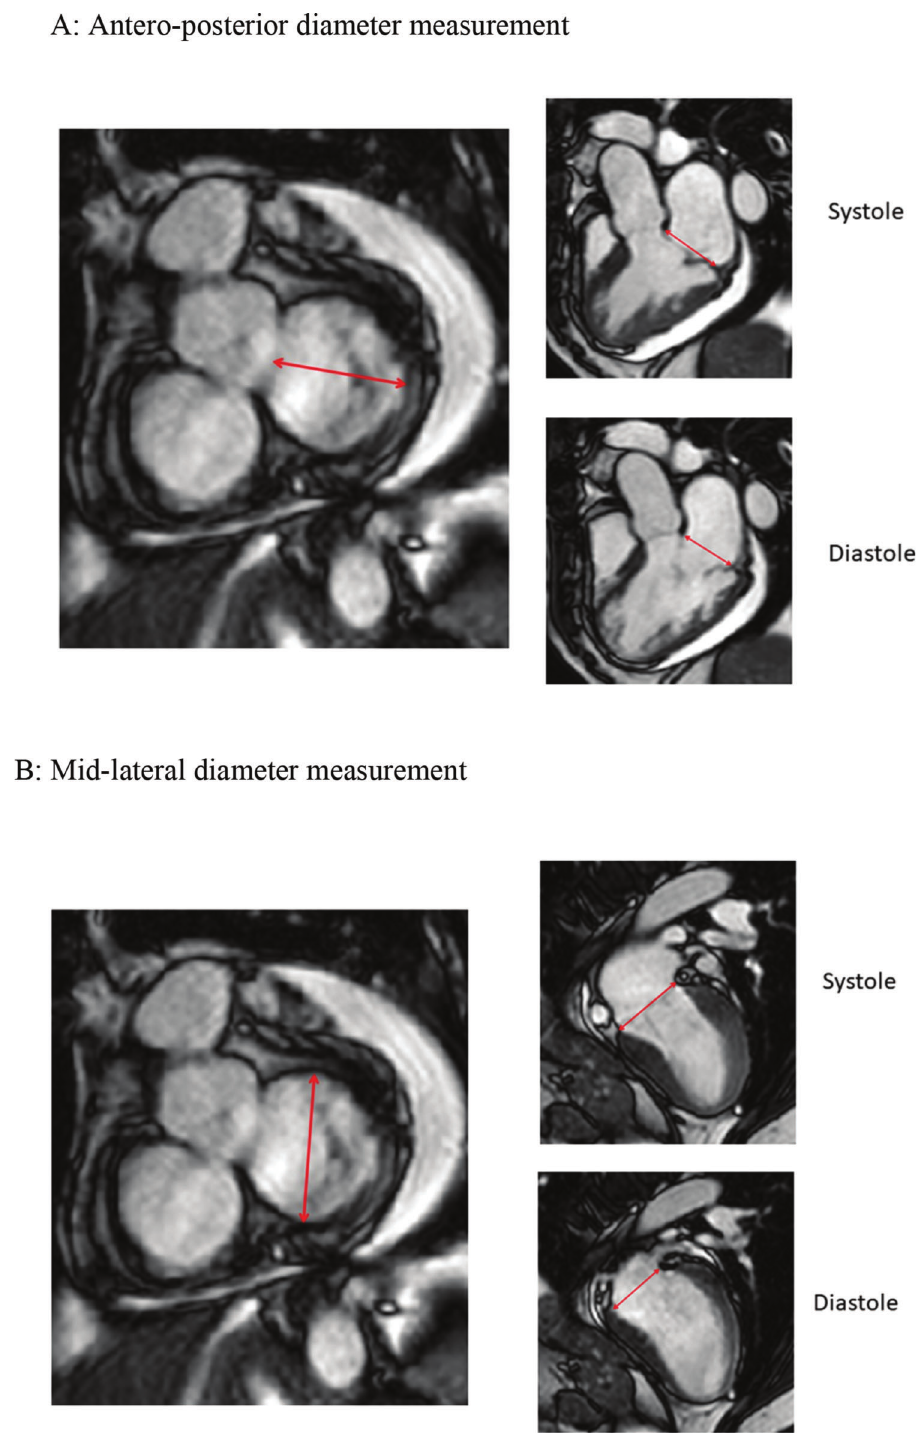
Figure 2 - Simultaneous imaging of the short and long axis grant for measurements of annular diameters. A: Measurement of the antero-posterior diameter of the mitral annulus in the short axis derives an image in three chambers in the long axis, where the mitral valve insertion limits and insertion points are adjusted and checked. B: Measurement of mid-lateral diameter derives two-chamber images on long